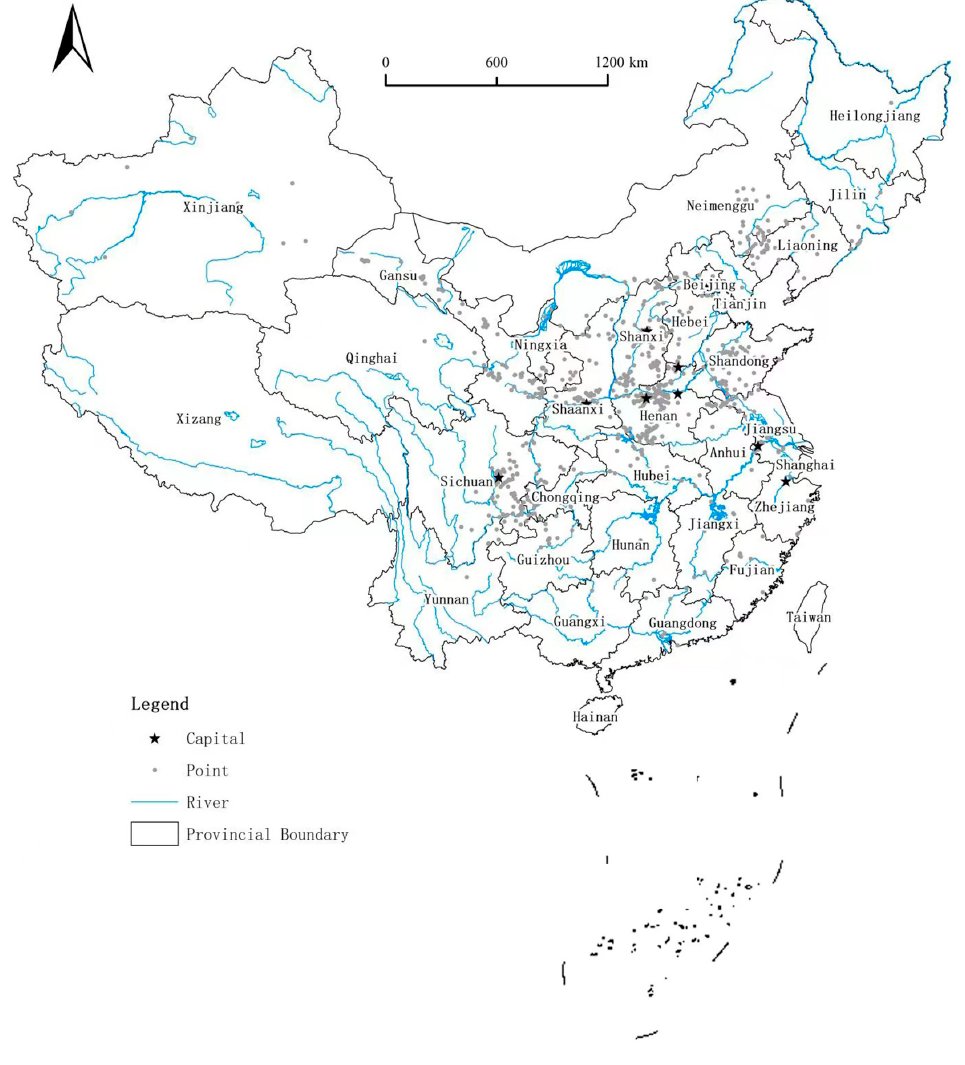
Figure 1. Distribution map of Chinese tomb mural relic sites.